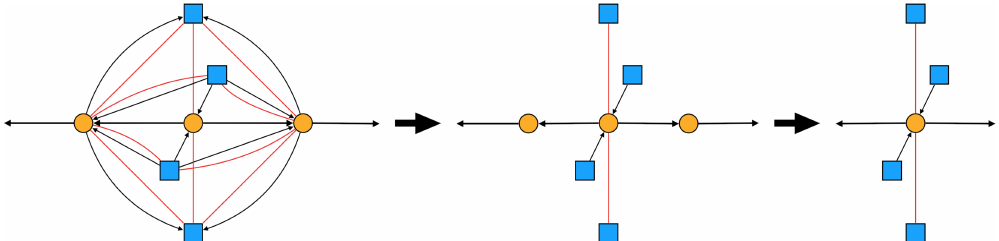
Figure 32 . The dual quiver representing the reduction of the n -cube model. (a) Configuration with massive fields obtained after triality on an intermediate cube. (b) Two nodes associated to bubbles arise after integrating out massive fields. (c) Triality on the bubble nodes reduces the